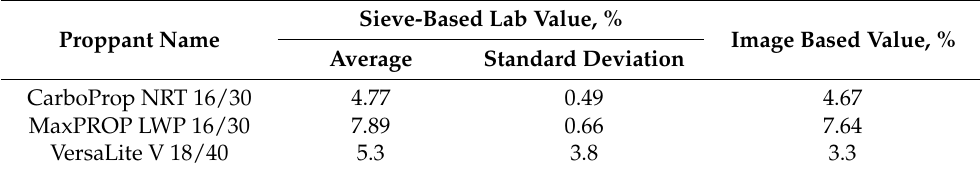
Table 3. Comparison of laboratory and image-based crush resistance tests for three proppant types.